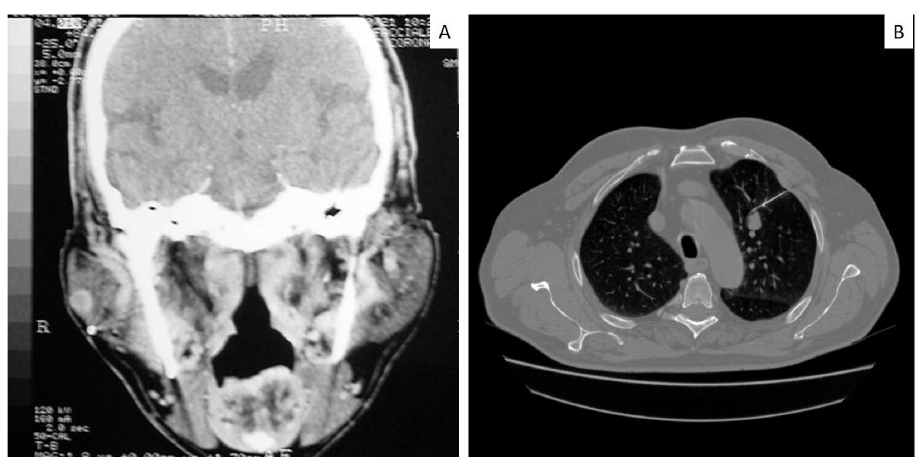
Figure 4. Metastatic lesion of the tongue ( A ) occurring in a patient already diagnosed with small cell carcinoma of the lung, as evident in PET scan ( B ), and with simultaneous brain metastasis ( C ).